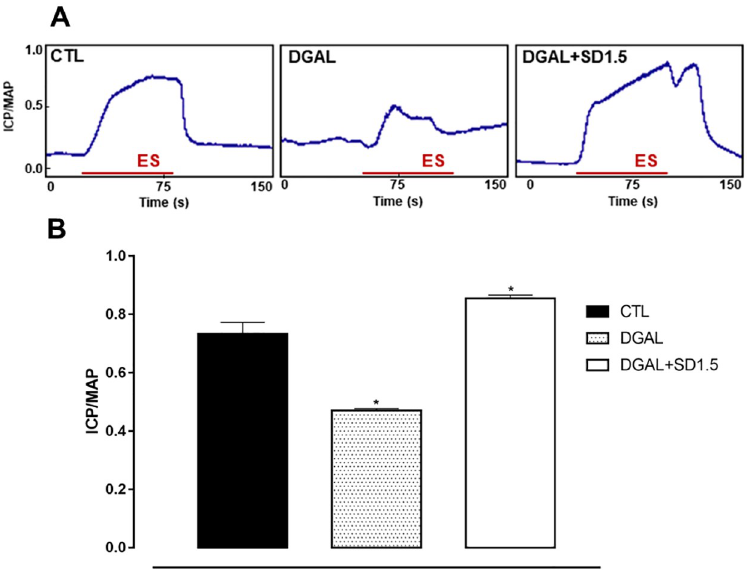
Fig 2. Original record (A) and statistical graph (B) of the ICP/MAP in response to electrical stimulation (16 Hz, 6V, 1 ms for 60 s) of the cavernous nerve in CTL and DGAL animals at eight weeks. Groups: CTL (vehicle); DGAL (D-(+)-galactose 150 mg/Kg); and DGAL+SD1.5 (D-(+)-galactose 150 mg/Kg + Sildenafil 1.5 mg/Kg). The results are expressed as mean ± SEM (n = 5). The data were analyzed using the Student’s t-test. � p < 0.05 vs CTL. ES: Electrical